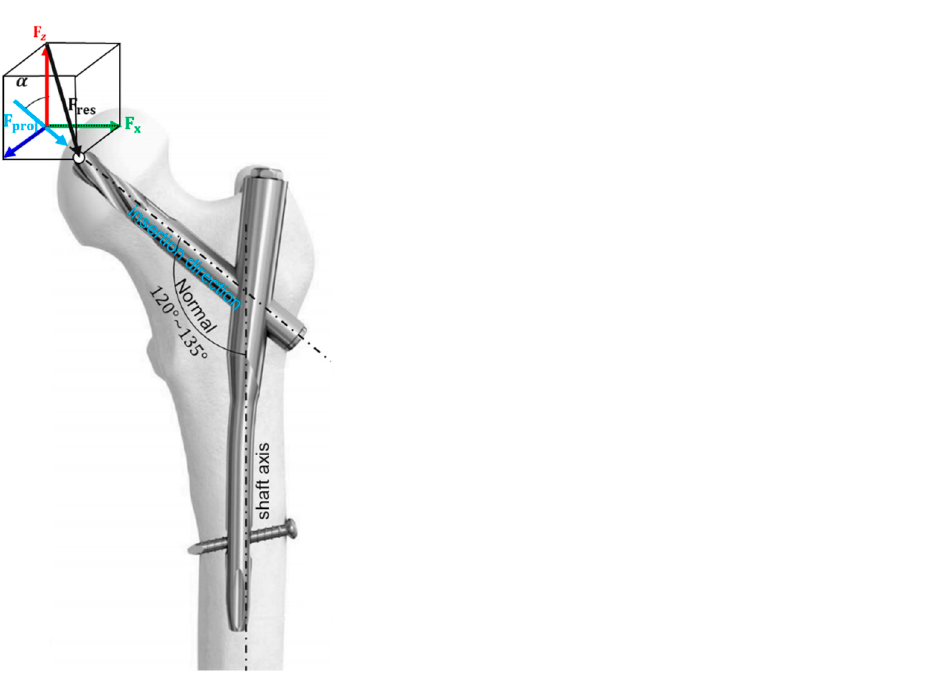
Figure 13. Relation between contact force on femoral head and pull-out force along insertion direction. When assuming the walking activity for a person weighing 100 kg, F proj ranges from 1323.8 N to 629.36 N, when α is 45 ◦ and 60 ◦ based on the HIGH100 data [36]. By applying the conversion factor, f AH = 1.55 [35], to the previous data for a 100 kg person, F proj for a person weighing 75 kg is calculated from 406.2 N to 854.1 N. Figure 14 represents the comparison of projected force and pull-out force from the experiment where the orange and blue band highlights the range of F proj for a 100 kg and 75 kg person,